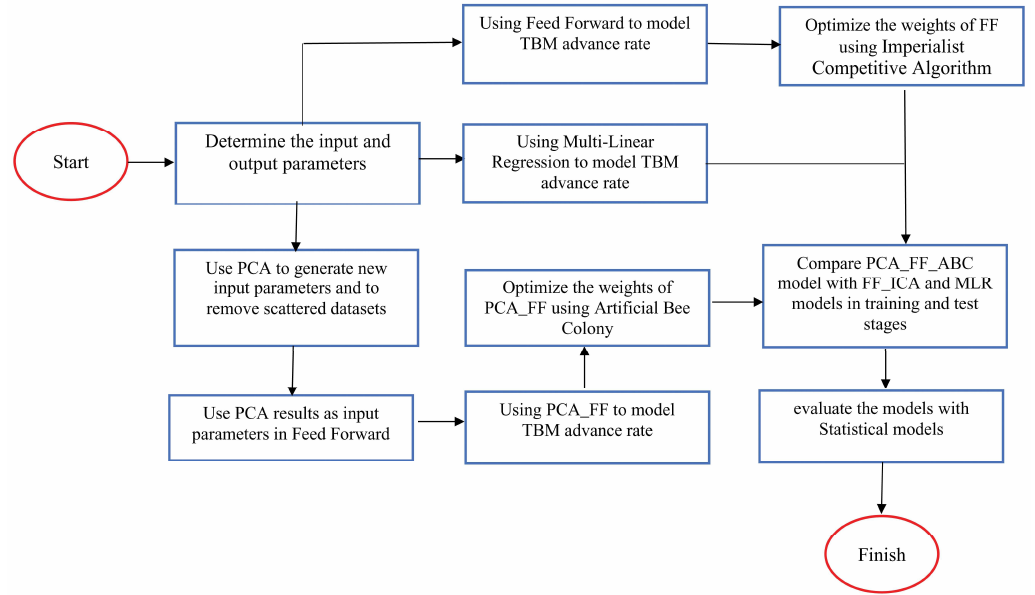
Figure 3. Flowchart of the study trend of a hybrid PCA and ANN optimized with the ABC algorithm.